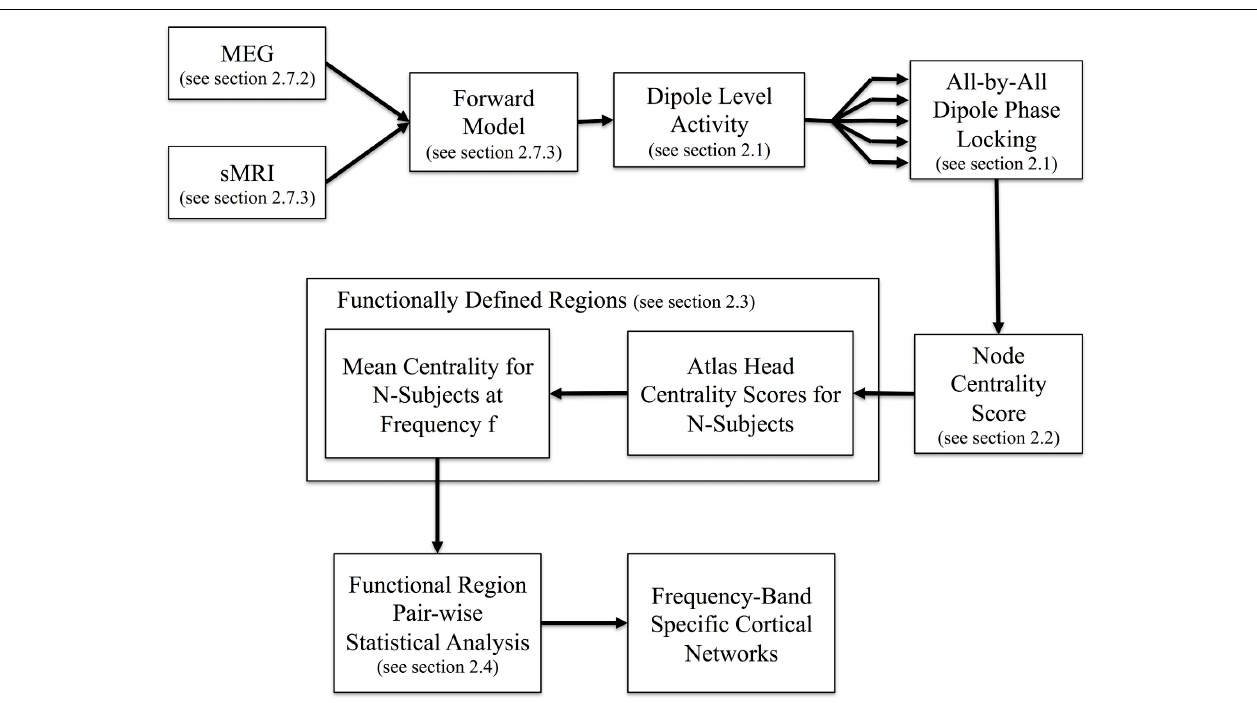
FIGURE 1 | Overview of method. Using inputs from MEG recordings and MRI structural information we reconstruct neural activity at each dipole on the cortical surface. The all-by-all dipole level phase locking is then calculated at the given frequency of interest for each subject before registration to a common